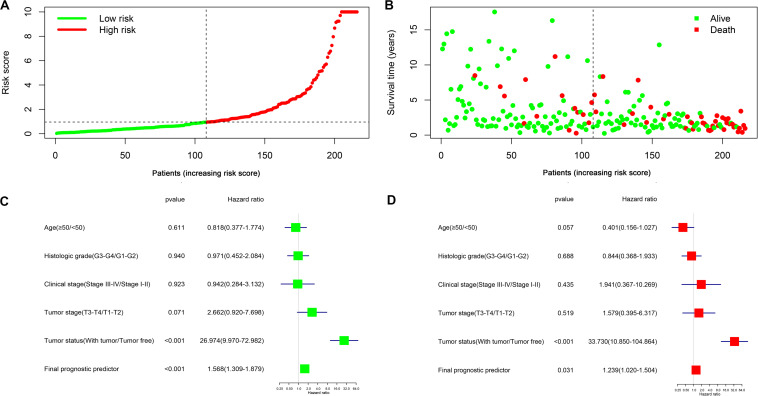
Identification capability of prognostic predictor for classifying CC patients into high and low risk groups. (A) The distribution of risk score for CC patients; high-risk (red) and low-risk (green). (B) Scatter plot shows the survival status and survival time of CC patients. Red dots denote patients that are dead and green dots denote patients that are alive. (C) Univariate Cox regression analysis. Forest plot of the association between risk factors and survival of CC patients. (D) Multivariate Cox regression analysis. The final prognostic predictor was an independent predictor of prognosis in in CC.